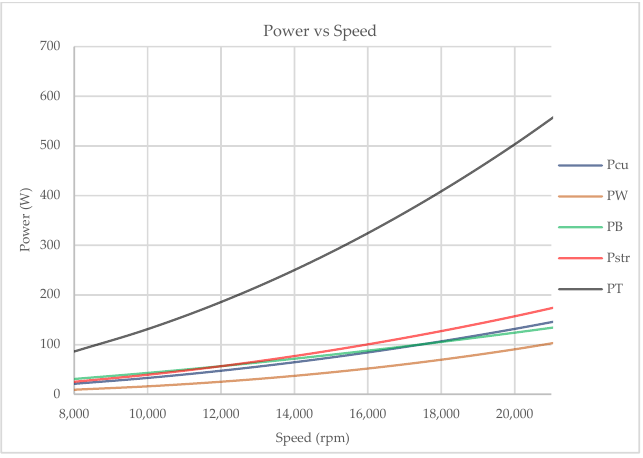
Figure 9. Windage, bearing friction, resistance, stray loss, and total power loss.